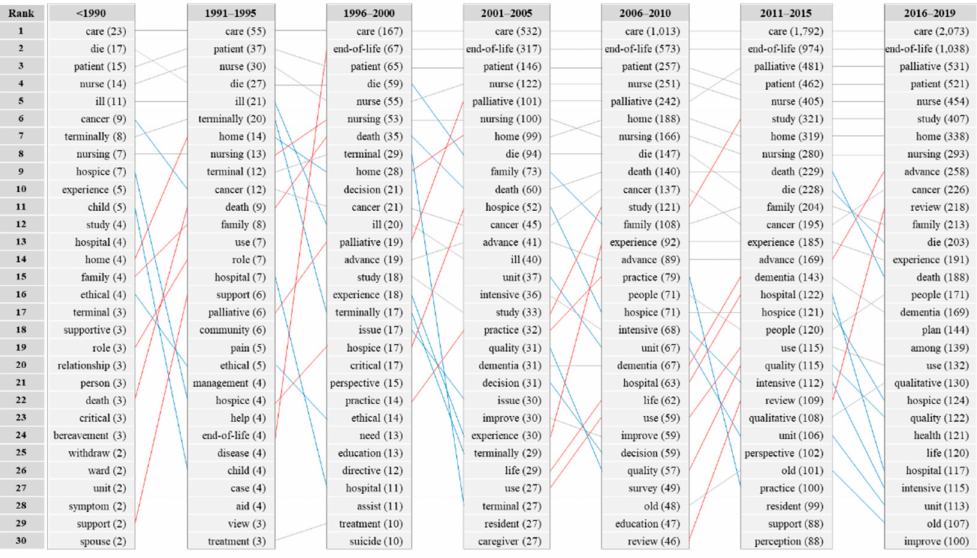
Figure 3. Keywords by five-years